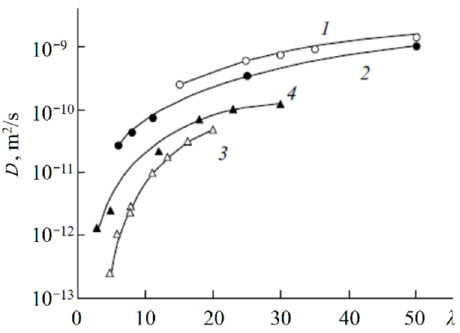
Figure 33. Diffusion coefficients of lithium cations in the system of lithium salt–disulfophthalic acid–water (1 is terephthalic PA-1 in Figure 34; 2 is isophthalic PA-2 in Figure 34) as a function of the moisture content in macroporous sulfonate cation-exchange CU-23 (4) and perfluorinated sulfonate cation-exchange membrane MF-4SC (3) [47]. Exchange capacity, mg-equiv/g: 0.86 for MF-4SC, 5 for macroporous cation exchanger CU-23, 2 for aromatic disulfo-containing polyamides [24].